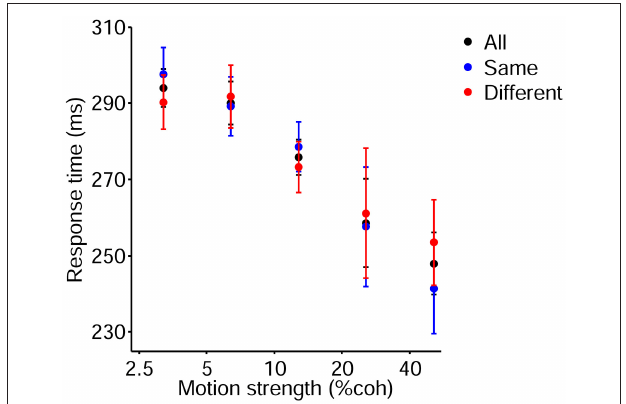
FIGURE 9 | Psychometric function of the current trials which includes motion strengths of 3.2, 6.4, 12.8, 25.6, and 51.2%. Red and blue data points depict response time of participants for the different and same decision conditions, respectively. Black data points are pooled from these two conditions. Error bars indicate SE (Standard Error).